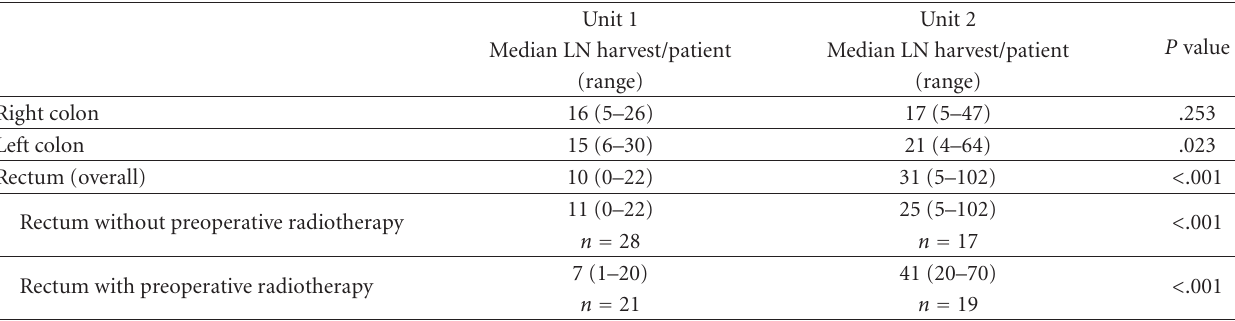
Table 2: Lymph node harvest according to tumour location between